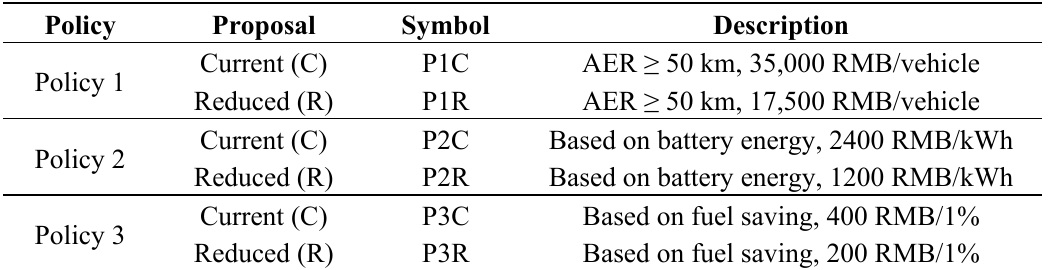
Table 5. Subsidy policies.